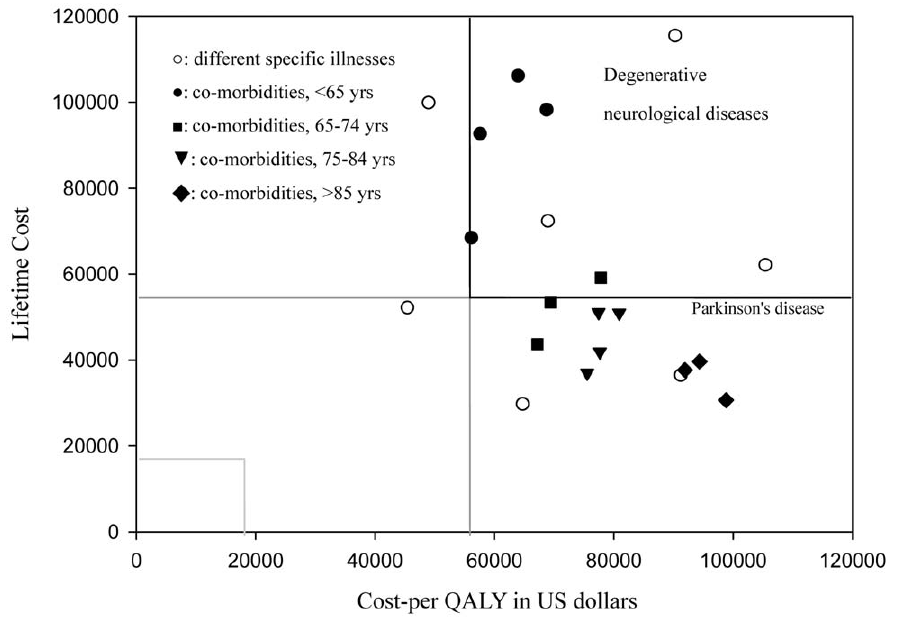
Figure 4. Plot of association between the cost-per-QALY (quality-adjusted life year) gained and the lifetime cost for different N diagnosis groups of PMV patients with partial cognition. , stratified by different specific illnesses [ # ] and multiple co-morbidities (indicated ], 65–74[ & ], 75–84[ . ], and . 84[ % ] years old). The GDP (gross domestic product) of Taiwan in 2010 was 18,588 US dollars, by sub-age groups, , 65[ below which the cost-per-QALY was considered as cost-effective; between 1–3 times the GDP per QALY gained was considered moderate cost- effective, and above 3 times the GDP per QALY gained was not cost-effective. The figure indicates there are many conditions showing a lifetime cost less than 3 times the GDP, although their costs-per-QALY were above that figure.